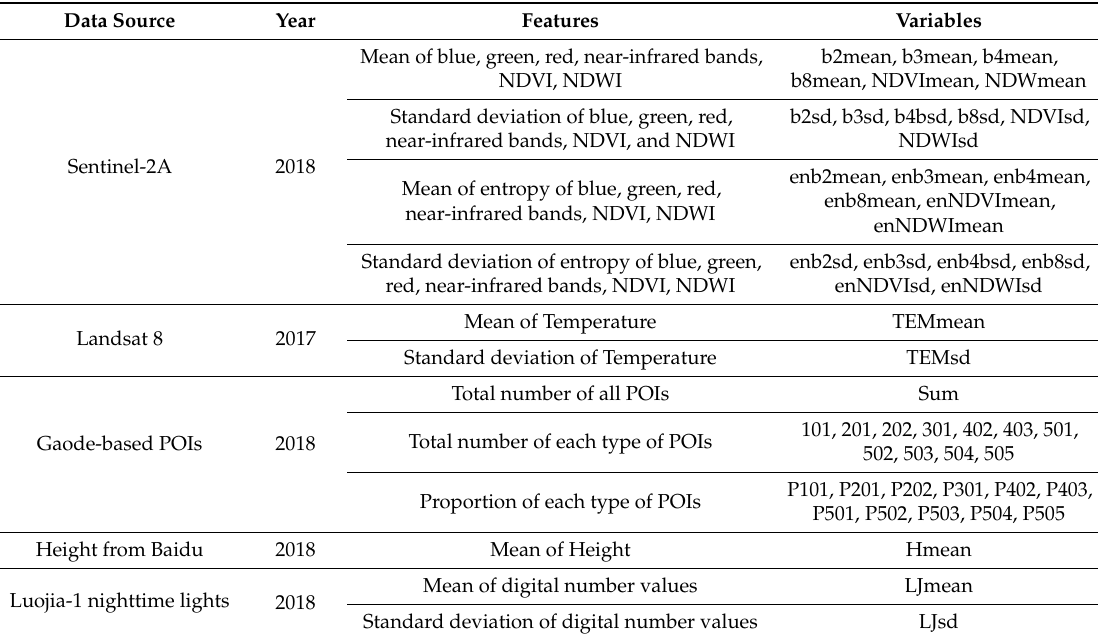
Table 2. Summary table of